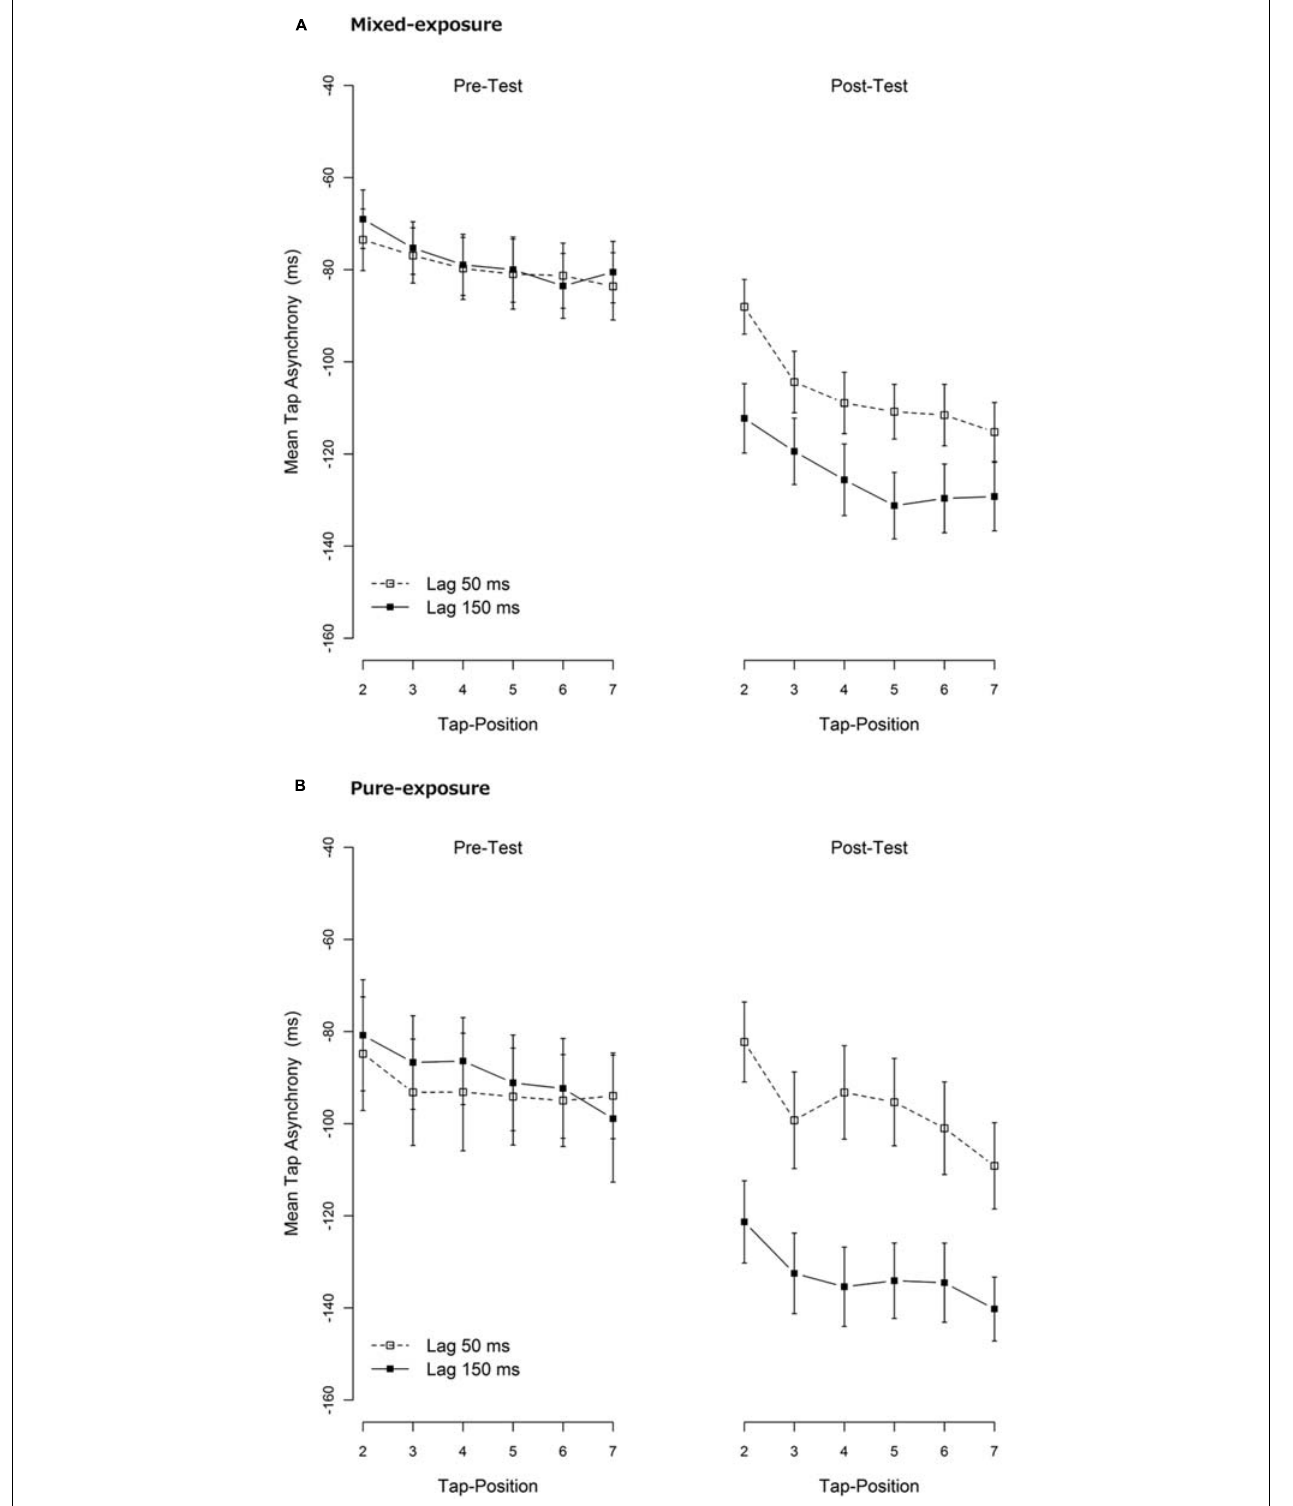
FIGURE 4 | Mean tap asynchronies per tap. (A) The mixed-exposure condition. (B) The pure-exposure condition.They were re-calculated from the same data as shown in Figure 3 . Data of the first tap-position were omitted